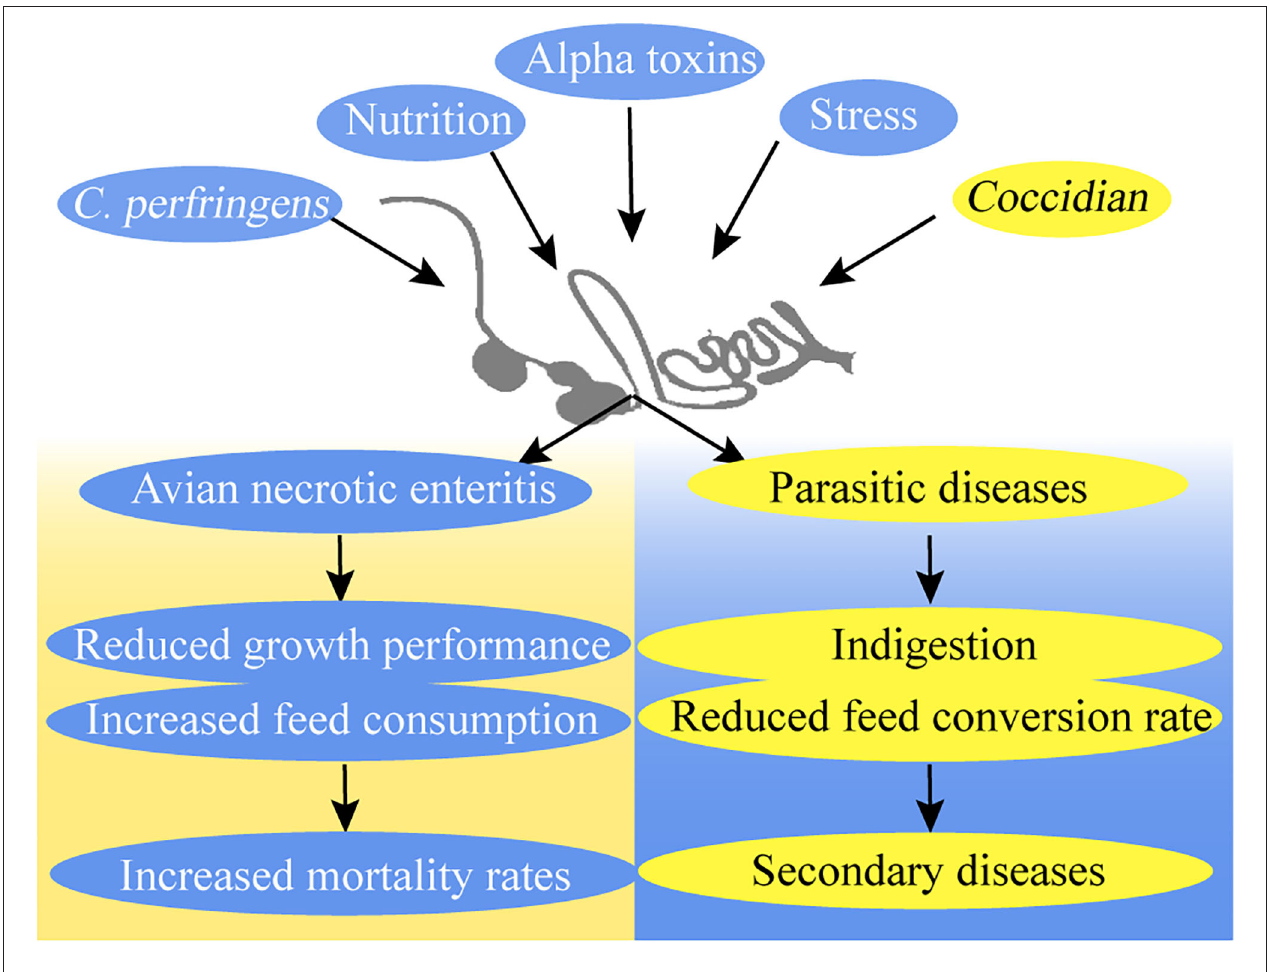
FIGURE 2 | Avian necrotic enteritis and parasitic diseases in broilers.